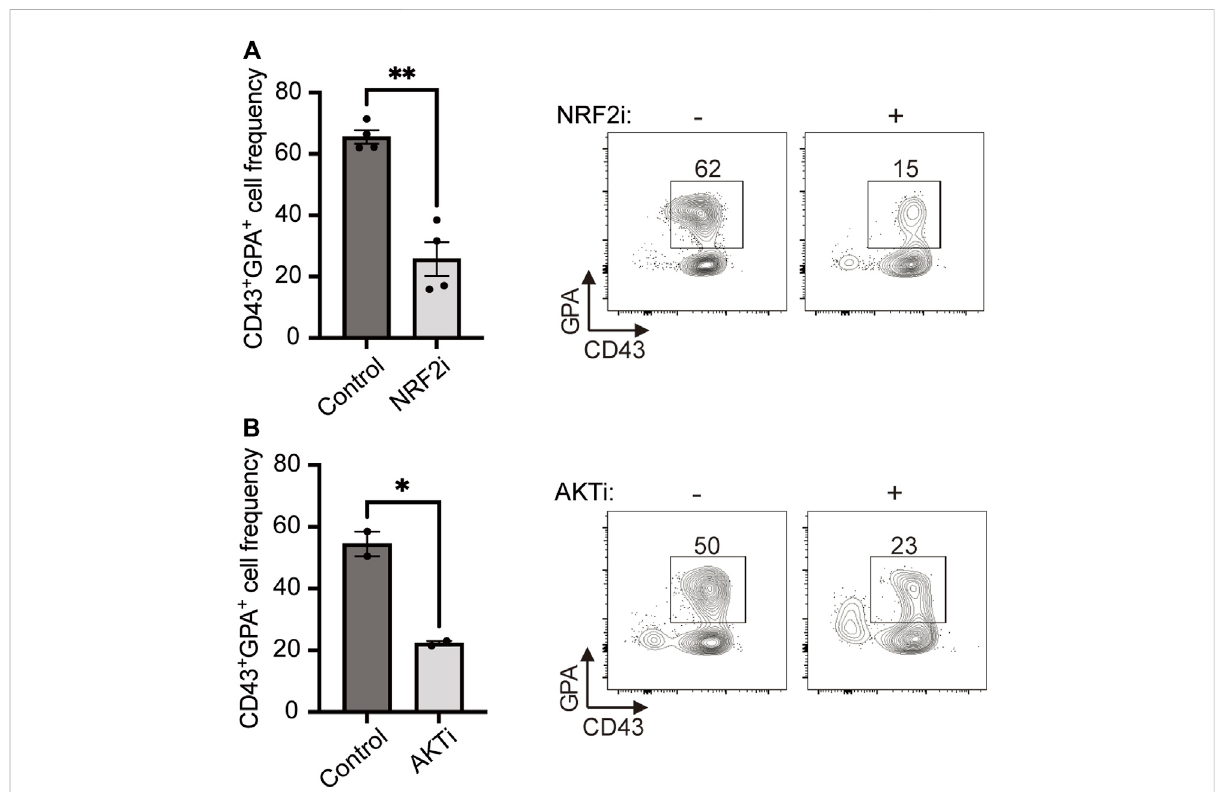
FIGURE 3 HE-derived erythroid cell differentiation requires NRF2 and AKT. (A,B) iPSC-derived HE cells were subcultured with NRF2i (A) or AKTi (B) for 6 days and compared to untreated cells. Representative plots and bar graphs showing CD43 + GPA + cell frequency ± SEM at day 6 are presented ( n